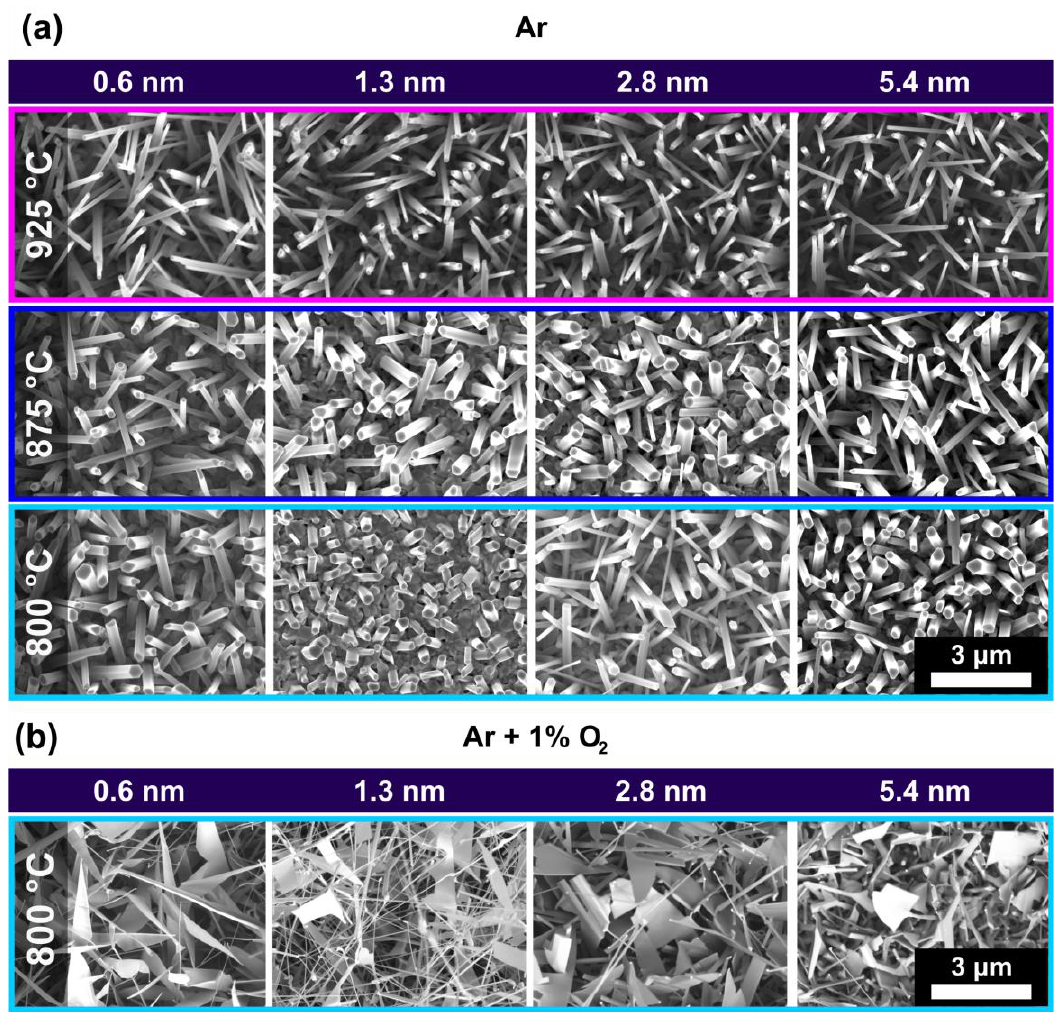
Figure 2. ( a ) Typical ZnO-nanostructures generated in a pure Ar–atmosphere at different temperatures and gold thin film layer thicknesses (0.6–5.4 nm) ( p = 12 mbar, t = 10 min, T source = 1020 °C). ( b ) Typical ZnO-nanostructures generated under the same conditions as ( a ) but in an Ar + O 2 (1%)–atmosphere. The colors match the temperatures and sample positions illustrated in Figure 1.